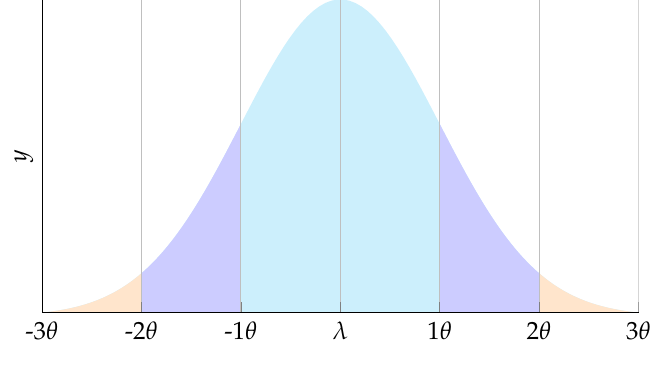
Figure 1. Normal